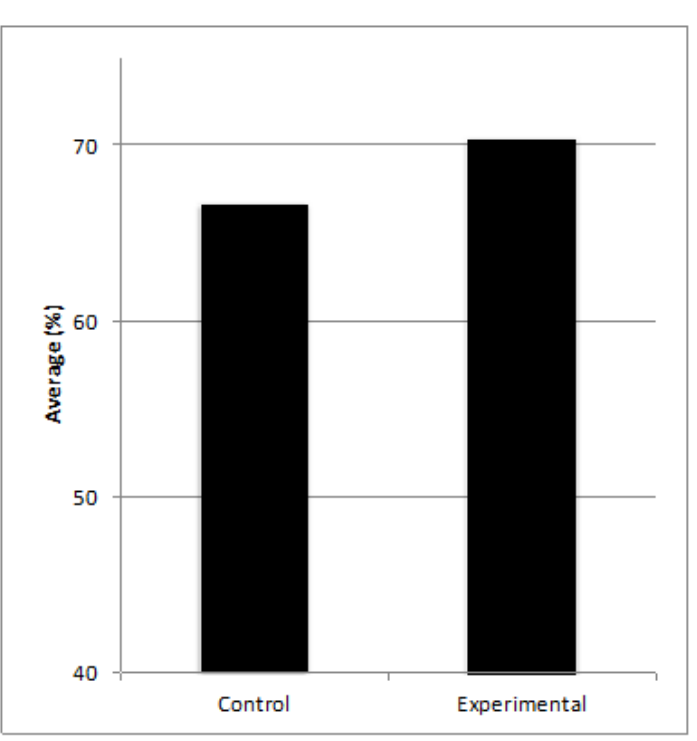
Figure 9. The overall averages for both the control and experimental groups for the